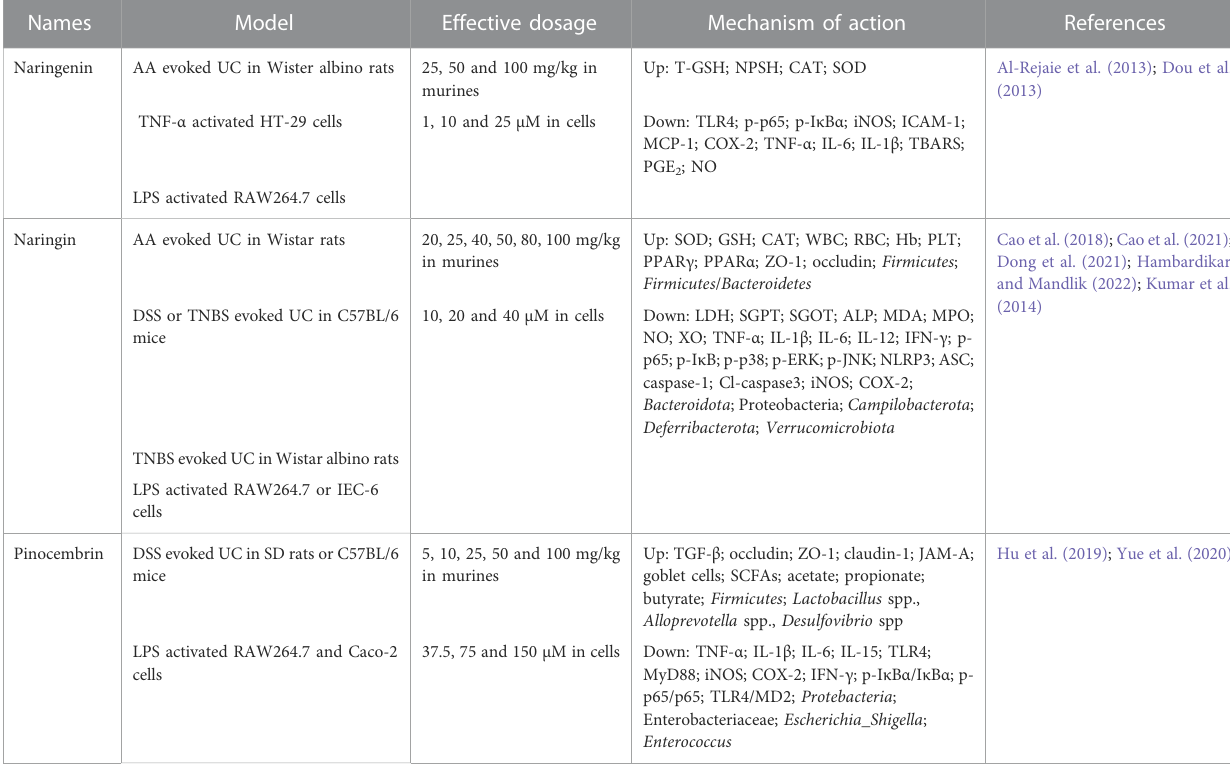
TABLE 2 ( Continued ) Molecular mechanisms of natural fl avonols and fl avanones against ulcerative